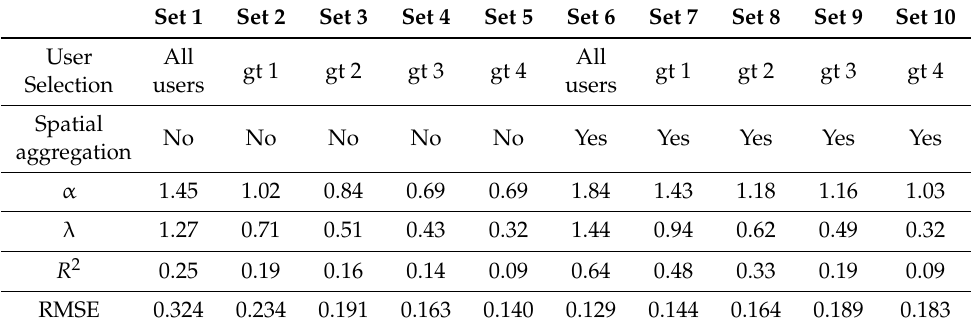
Table 3. The effects of different sample